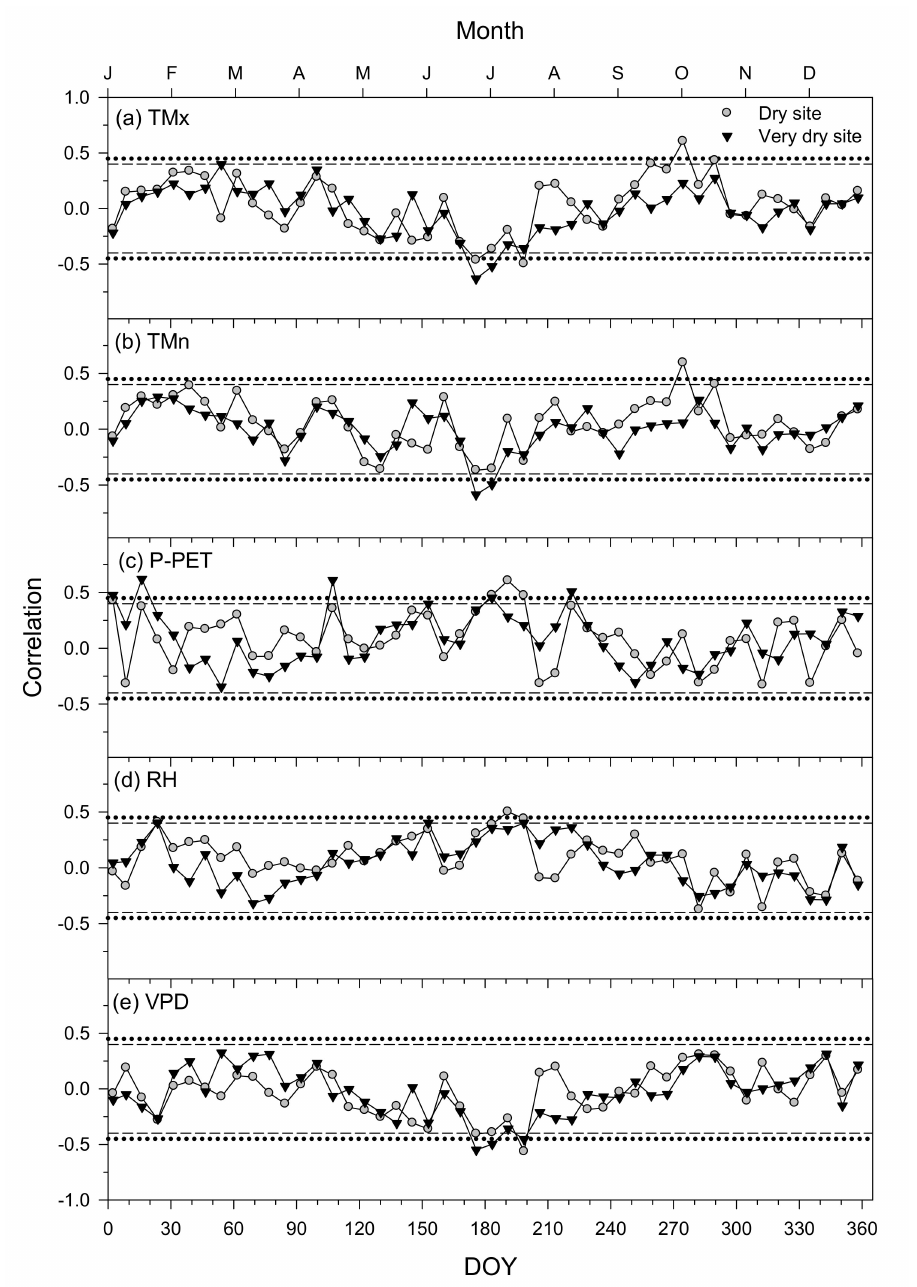
Figure 7. The climate–growth relationships of Ephedra nebrodensis were assessed at a weekly resolution at the dry and very dry sites. The analyzed climate variables were ( a ) TMx—mean maximum temperature, ( b ), TMn—mean minimum temperature, ( c ) P-PET—climatic water balance, ( d ) RH— relative humidity, and ( e ) VPD—vapor pressure deficit. The horizontal dashed and dotted lines indicate the 0.05 and 0.01 significance levels,